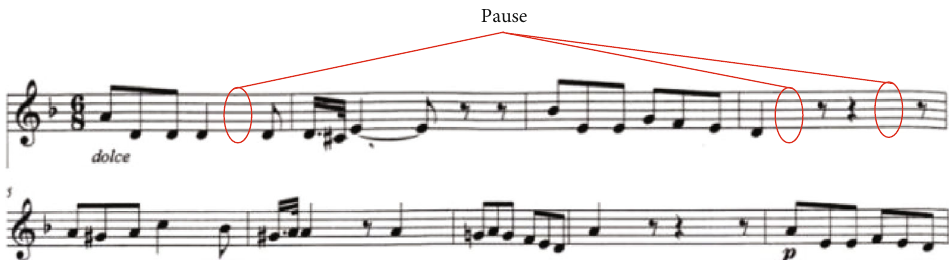
Figure 6: Schematic diagram of breathing pause in music